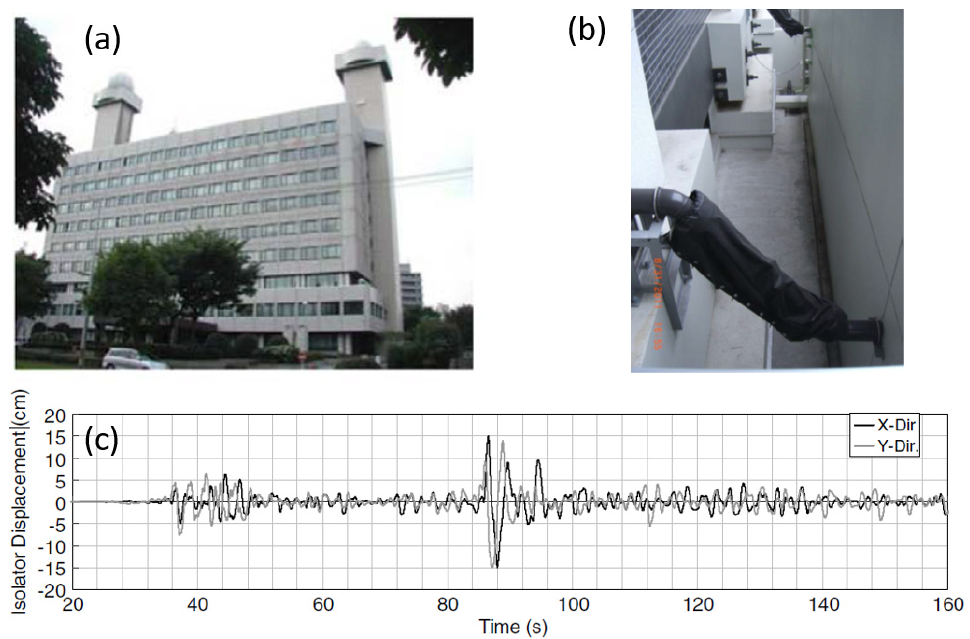
Figure 18. ( a ) Story SI building in Sendai, Miyagi Prefecture. ( b ) Spacing. ( c ) Estimated displace- ment response at isolation interface by double integration of acceleration waveforms in X and Y directions [60].